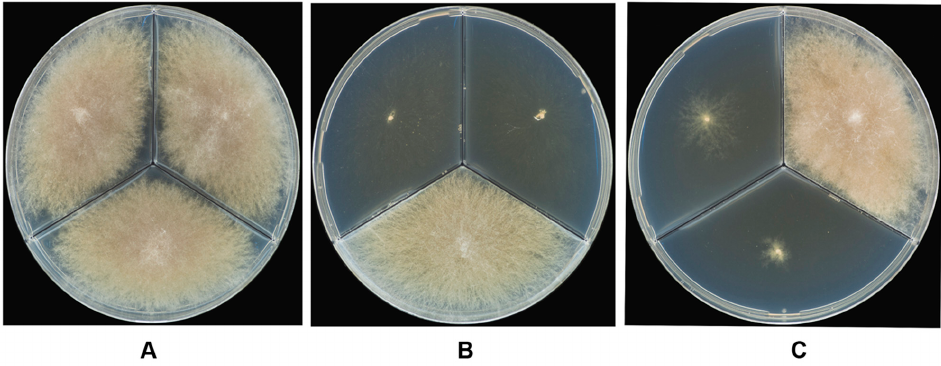
Figure 4. The growth behavior of F. langsethiae strains on CZ with the corresponding nutrients added in three sections of Petri dish: the left—vitamin-free CZ; the right—CZ + 0.01 mg/L biotin; the bottom—CZ + 0.1 mg/L thiamin. ( A ) The prototroph MFG 220101; ( B ) The thiamine auxotroph MFG 225405; ( C ) The biotin auxotroph MFG 11110. Their growth states were recorded and pictures were taken after cultivation at 24 °C for 10 days in darkness.